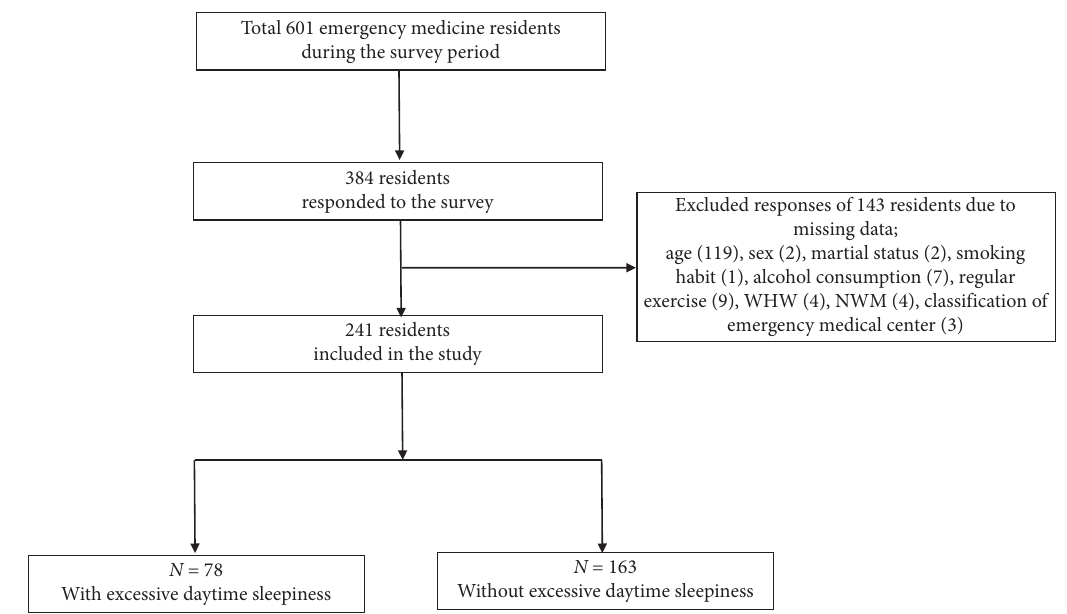
Figure 1: Flow chart of the study. WHW: working hours per week; NWM: night working days per